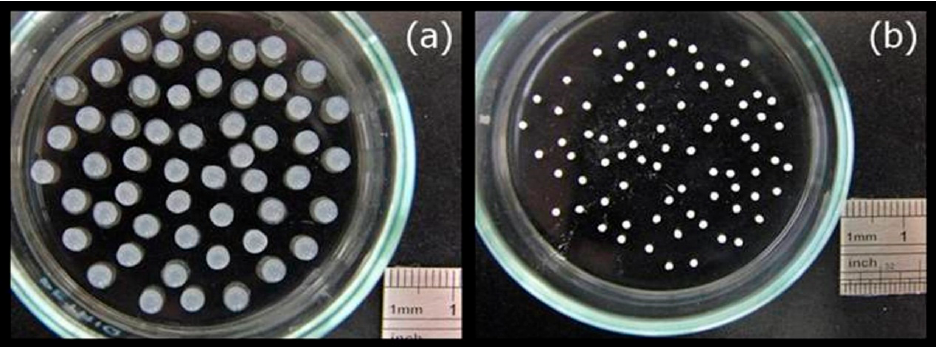
Figure 2. Optical images of ( a ) MBGNF/alginate gel beads and ( b ) MFBs.